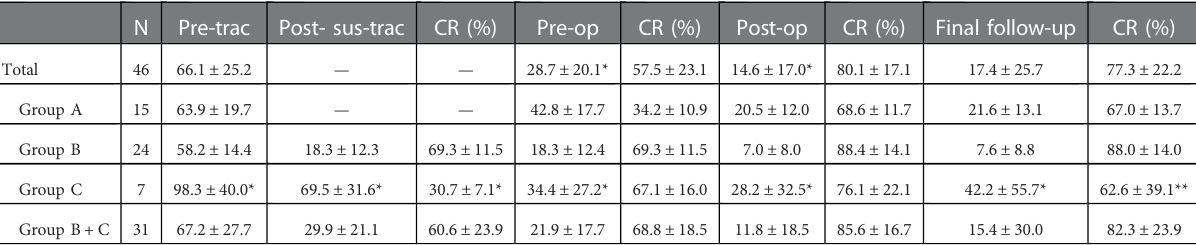
TABLE 4 The change of Cobb angle in operative region